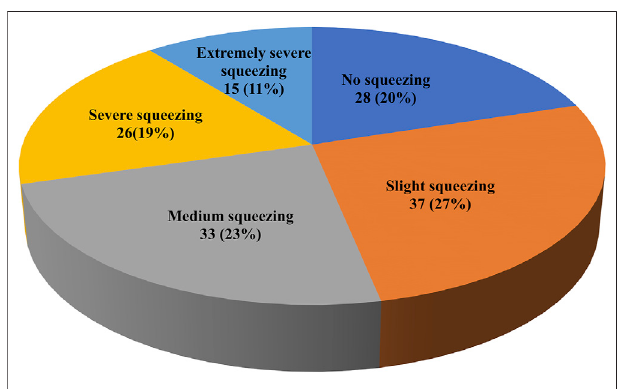
FIGURE 3 | Proportion of different squeezing levels in the